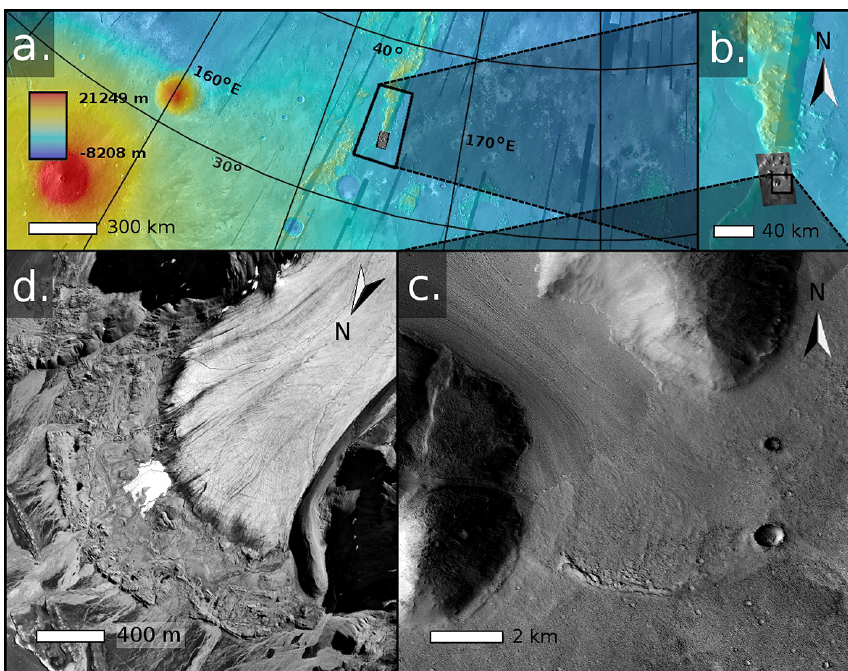
Figure 3. Case study illustrations of the former extent of martian GLF #146 showing background MOLA elevation images ( a and b ), and a CTX image expansion (c) . The forefield of terrestrial Midre Lovénbreen, Svalbard, is shown for comparison (d)